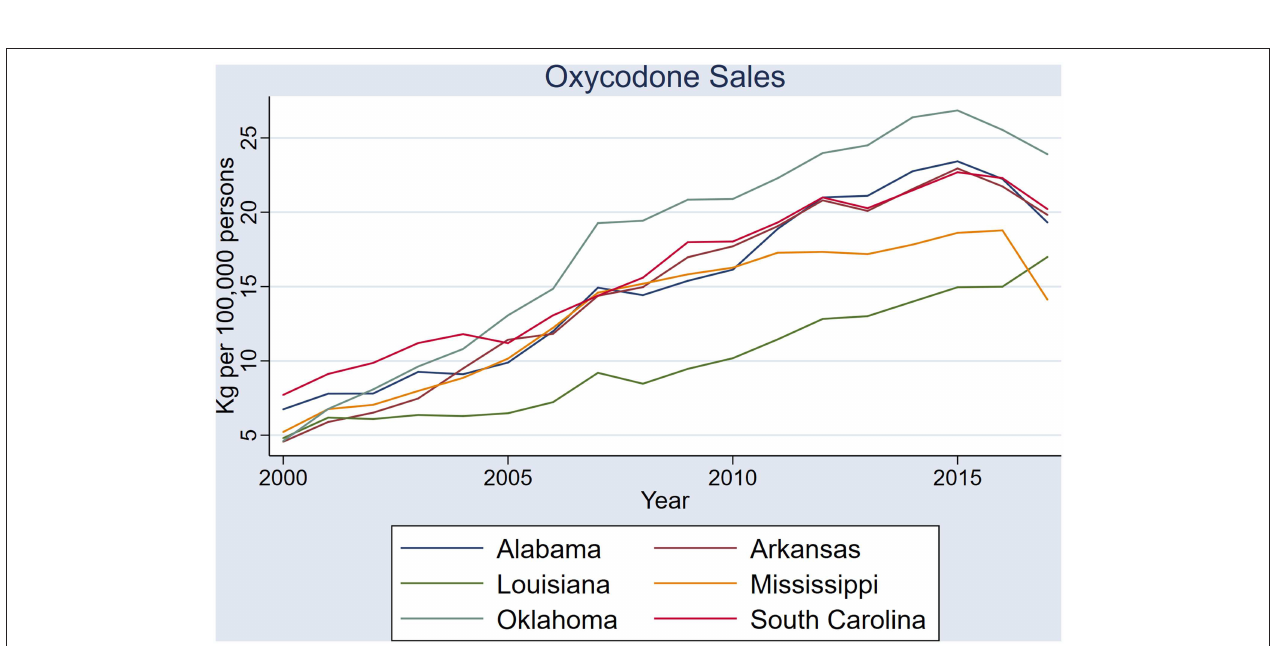
NHW45-54 medical-cause mortality [rs (13) = 0.540; P = 0.038] ( Figure 9 ); and oxycodone exposure correlated with male NHW45-54 medical-cause mortality [rs (13) = 0.607; P = 0.016] ( Figure 10 ). Correlations were not seen between hydrocodone sales and male mortality [rs (13) = 0.257; P = 0.355], or oxycodone sales and female mortality [rs (13) = 0.075; P =